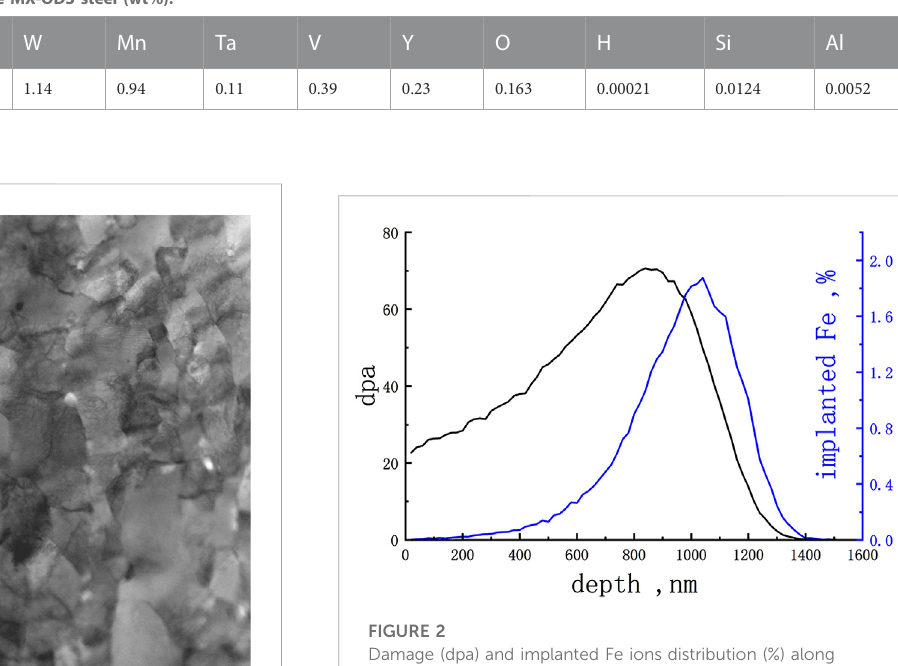
TABLE 1 Chemical composition of the MX-ODS steel (wt%).